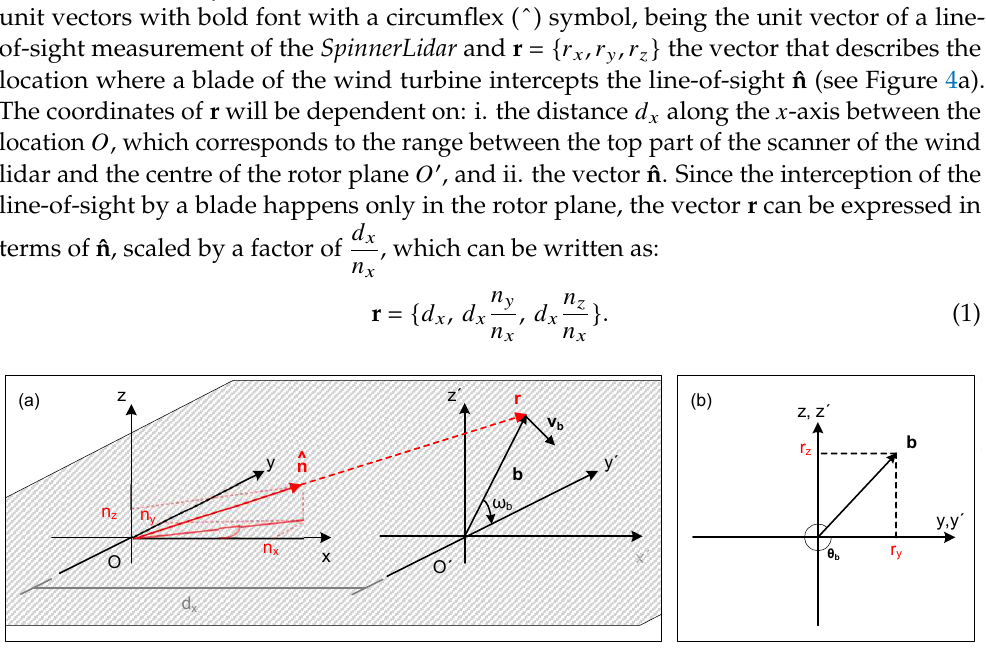
Figure 4. Graphical illustration from ( a ) a perspective and ( b ) a front (looking towards the wind turbine) view of the 𝑥𝑦𝑧 coordinate system used to define the line-of-sight vector r of a radial measurement at any point of a wind turbine blade rotating in the 𝑦 (cid:48) 𝑧 (cid:48) plane when the wind lidar’s pointing direction is aligned to the centre of the rotor (Case